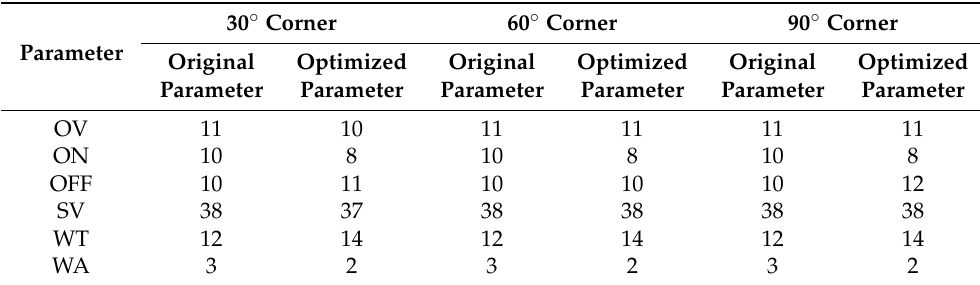
Table 12. Original parameters and optimized parameters obtained from the developed optimization system.